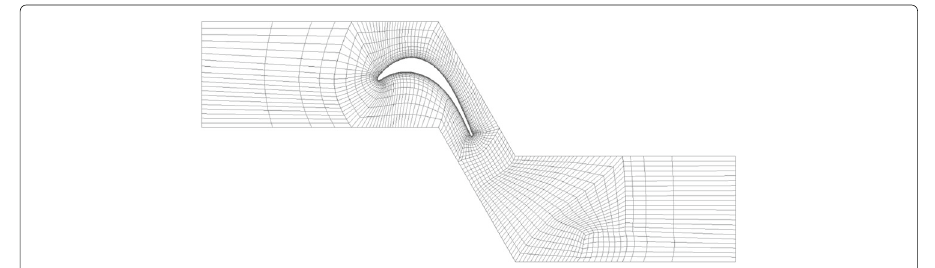
Fig. 1 Coarse mesh